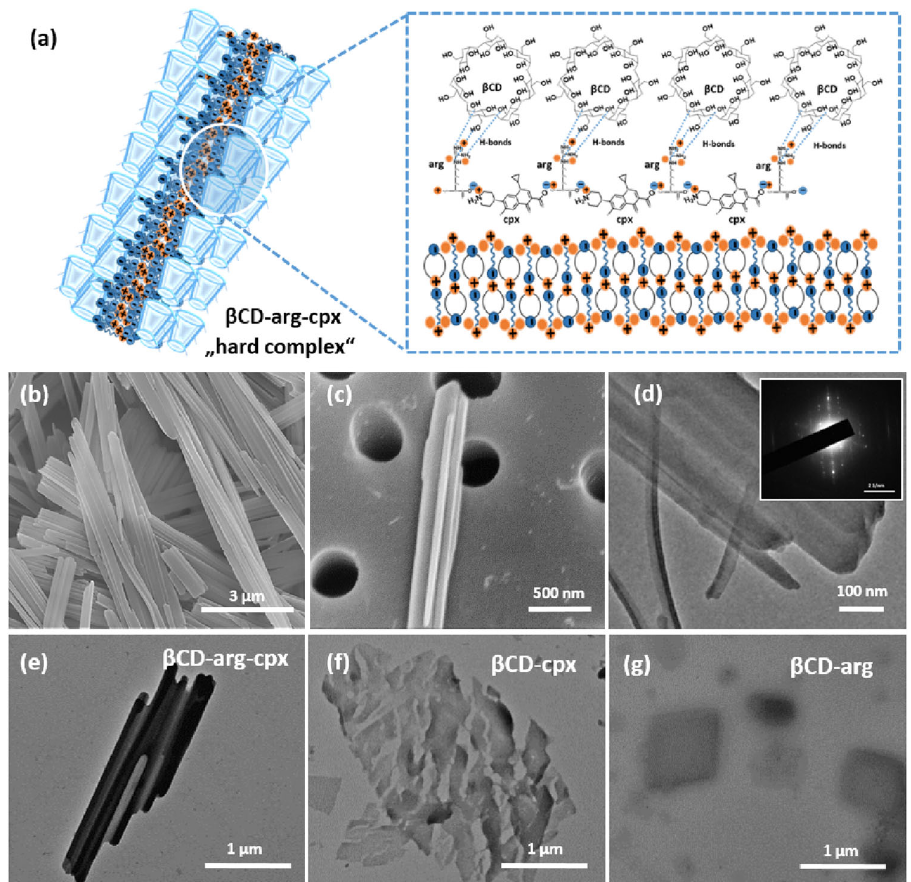
Fig. 1 Structural properties of more stable β CD-arg-cpx complex. Illustration of the structure with an arg-cpx crystalline core and β CD at the surface ( a ). SEM morphology showing long, aligned, rod-like structures of β CD-arg-cpx complex ( b ) with sharp, nanothick edges ( c ). Higher-magni fi cation TEM image of the β CD-arg-cpx rods ( d ) and EDS pattern showing their crystalline nature (insert in ( d )). TEM structures revealing differences among β CD-arg-cpx ( e ), β CD-cpx ( f ) and β CD-arg ( g